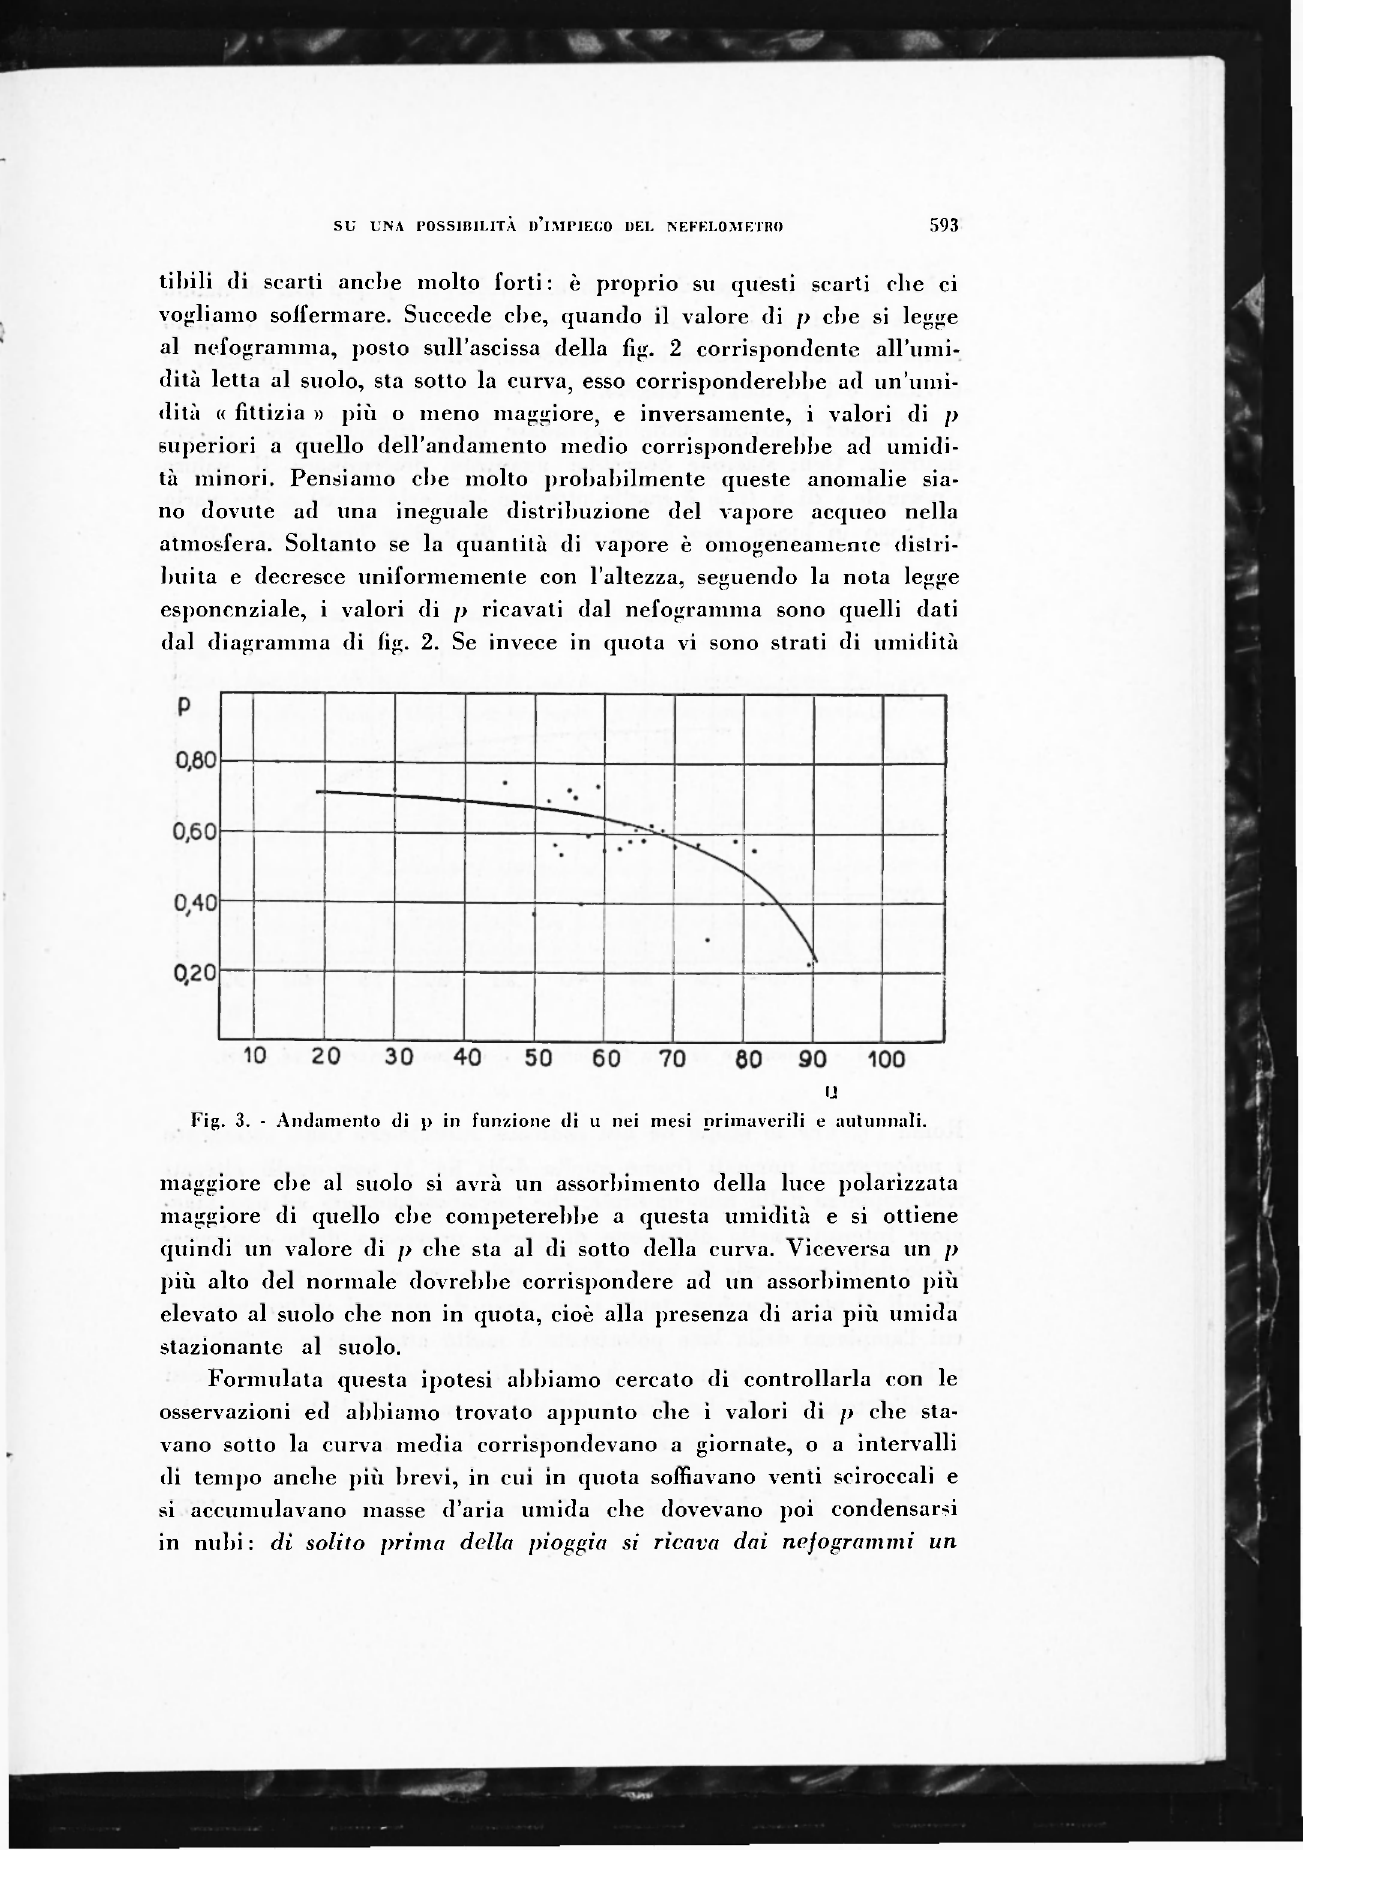
Fig. 3. - Andamento di p in funzione di u nei mesi primaverili e